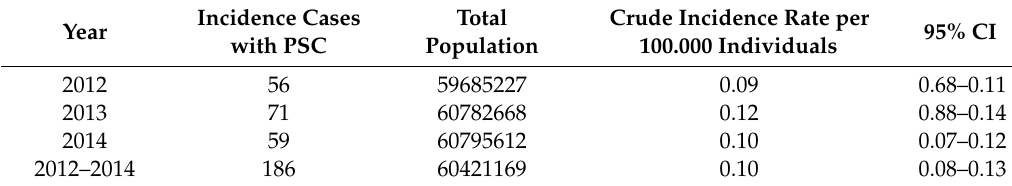
Table 2. Incidence cases with primary sclerosing cholangitis and crude incidence rate per 100,000 individuals from 2012 to 2014.